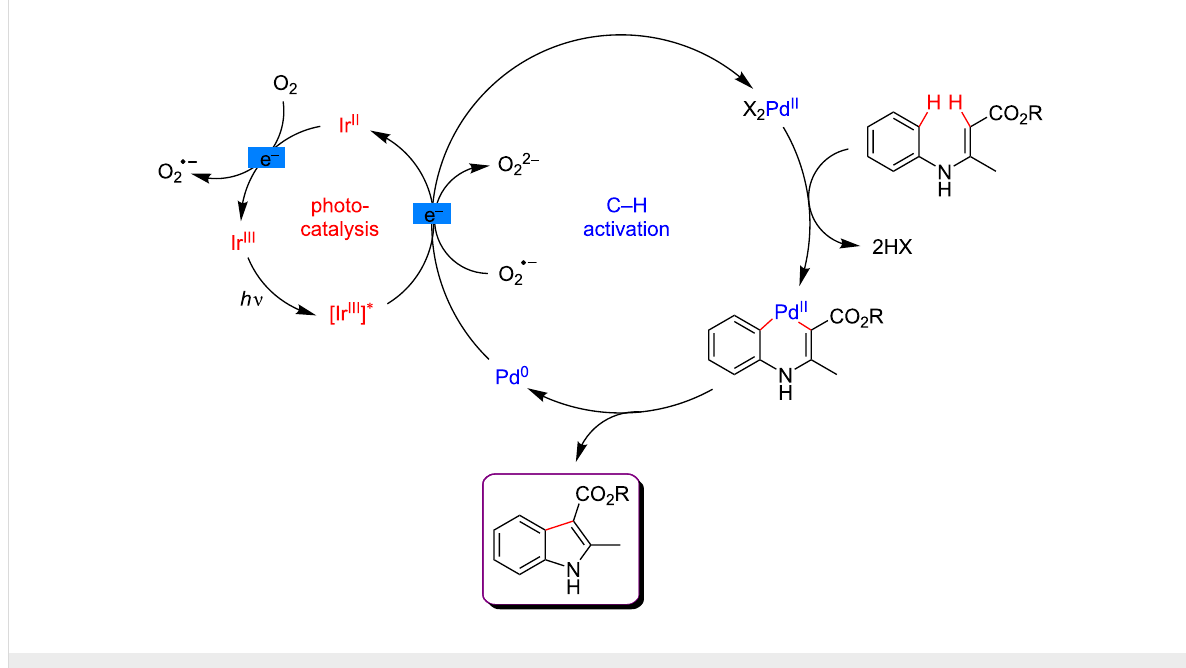
Figure 6: Proposed mechanism for the indole synthesis via dual catalysis.